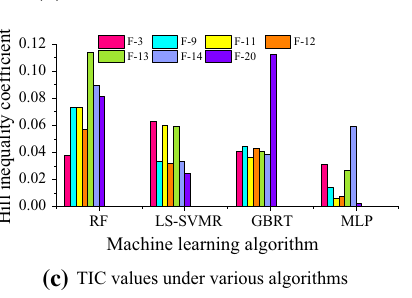
Fig. 5 Evaluation index of various algorithms using different param- eter combinations